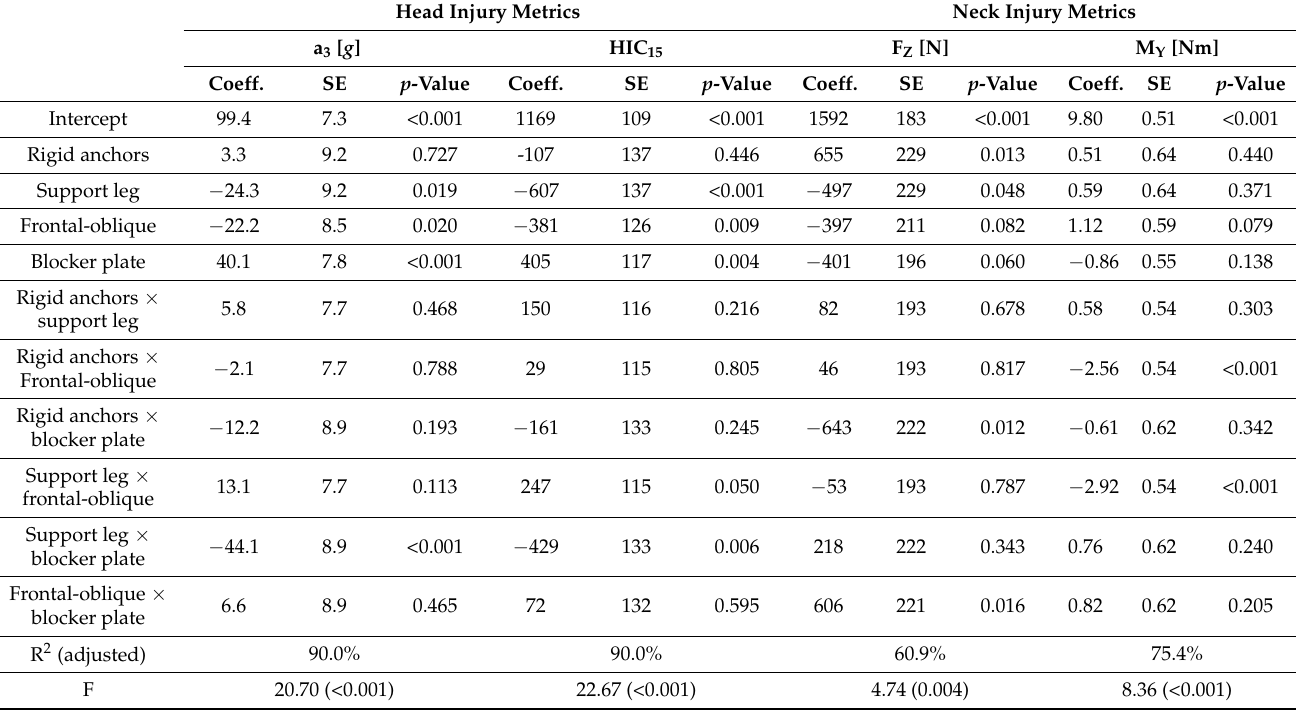
Table 5. Multiple linear regression of head and neck injury